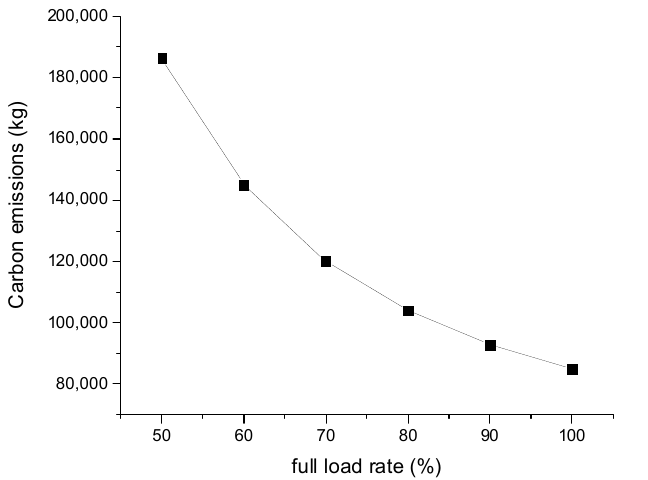
Figure 2. Carbon emission variation of prefabricated component transportation under different full ‐ load rates.